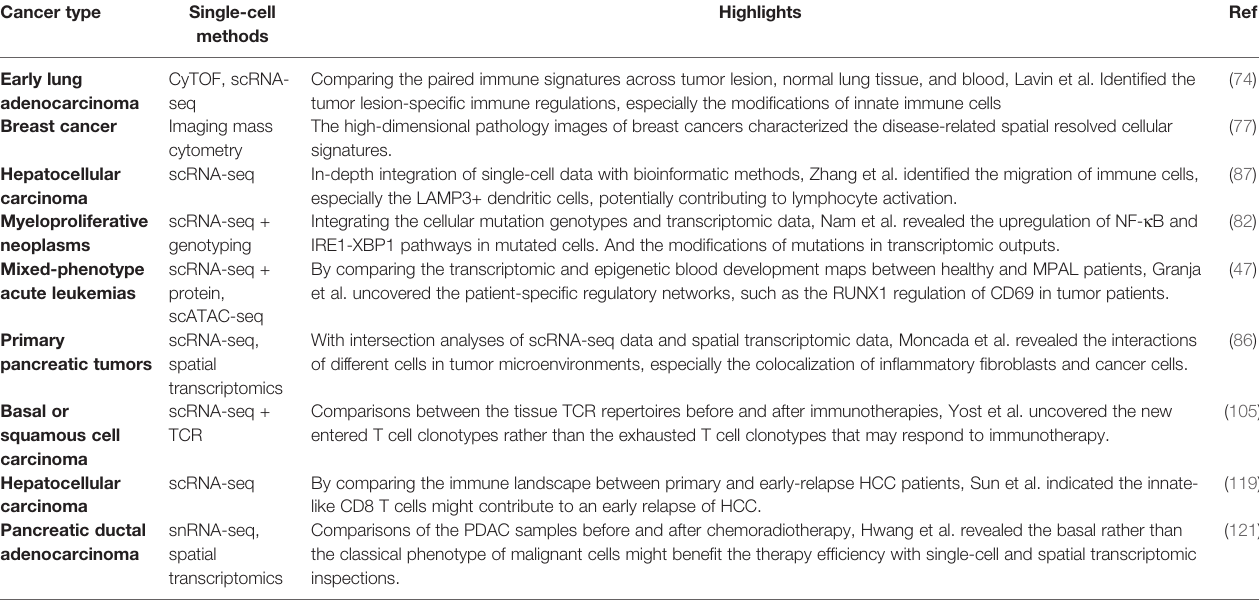
TABLE 1 | Selected cancer research with Single-Cell omic